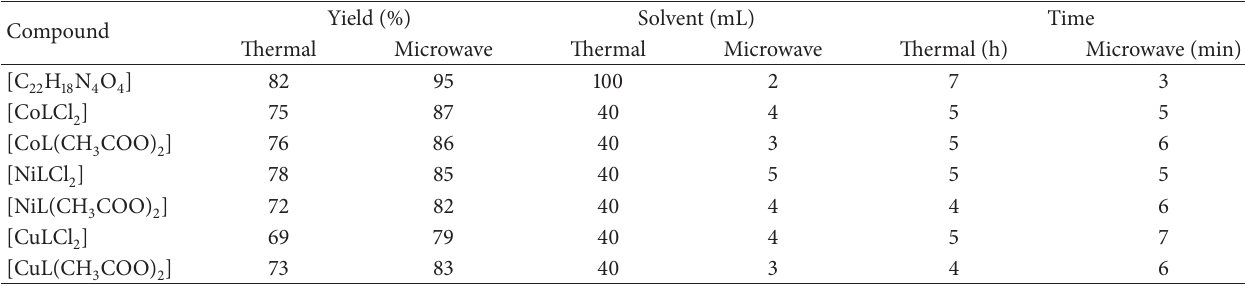
Table 1: Comparison between microwave and thermal